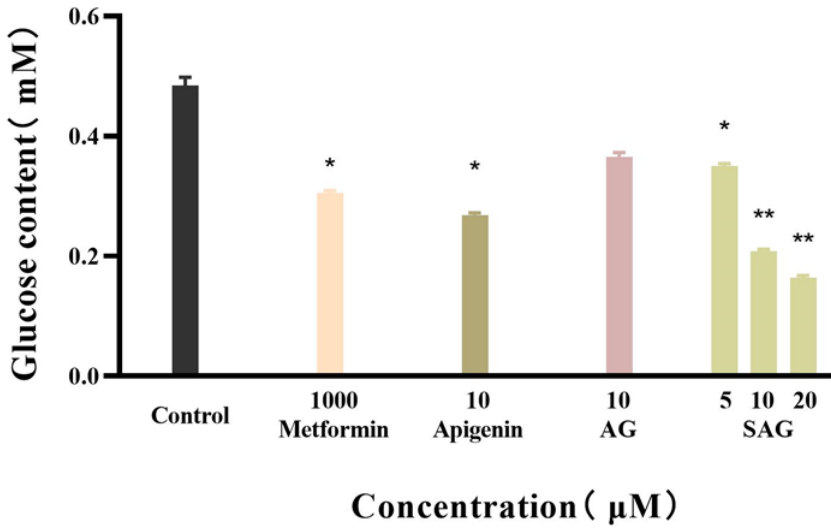
Figure 4. Glucose content of the apigenin and derivatives (* p < 0.05 vs. control group, ** p < 0.01 vs. control group, n = 3).